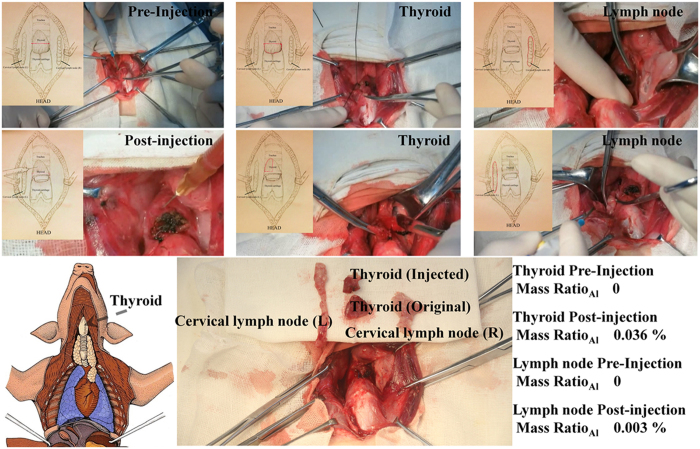
Orthotopic injection.Mass ratio of Al in thyroid and lymphnodesbefore and after KI@DOX-KaolinMeOH injection.